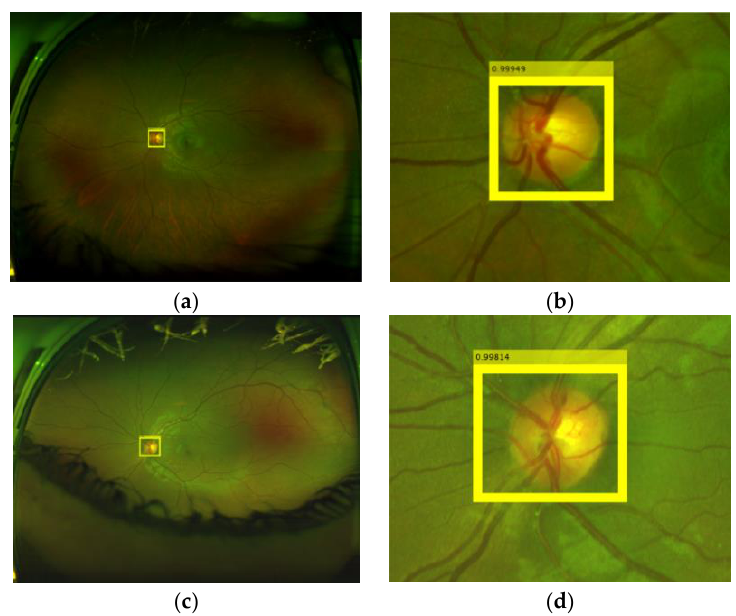
Figure 11. Examples of OD detections. ( a , b ) OD detection in the input image, ( b , d ) are amplified version of ( a , c ), respectively.